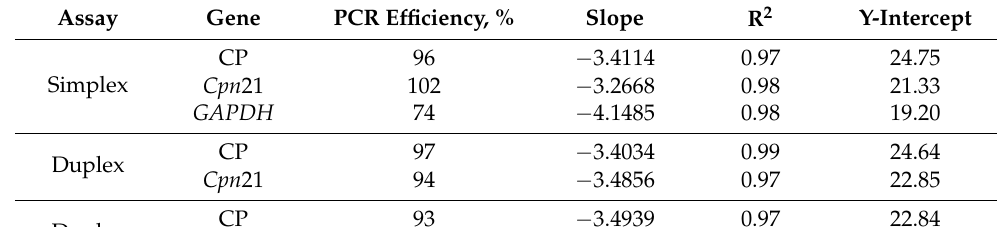
Table 1. Calibration curve parameters of the simplex and duplex qPCR assays.